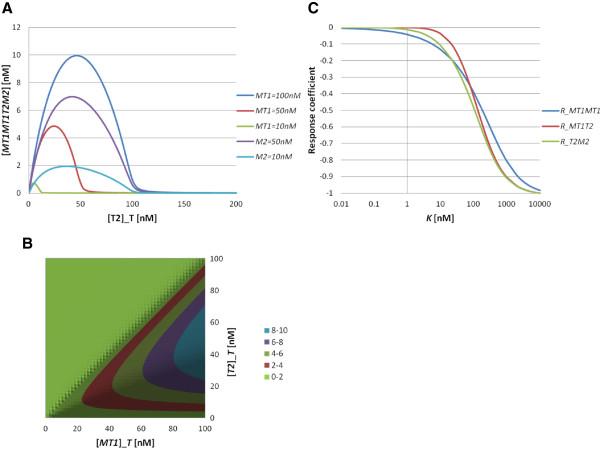
Behaviour of the steady state of the MMP model. (A) Complex concentration [MT1MT1T2M2] as a function of total TIMP2 concentration for different total MT1-MMP and MMP2 concentrations. Blue line indicates [MT1]T = 100nM, [M2]T = 100nM. Red line indicates [MT1]T = 50nM, [M2]T = 100nM. Green line indicates [MT1]T = 10nM, [M2]T = 100nM. Purple line indicates [MT1]T = 100nM, [M2]T = 50nM. Cyan line indicates [MT1]T = 100nM, [M2]T = 10nM. (B) Concentration map of the complex concentration [MT1MT1T2M2] as a function of total MT1-MMP and TIMP2 concentrations. Here, we set [M2]T = 100nM. (C) The response coefficients of the MMP model for the three interactions: the MT1-MMP dimerization, the MT1-MMP and TIMP2 binding, and the TIMP2 and MMP2 binding. The blue line shows the response coefficient RMT1MT1 = ∂ ln [MT1MT1T2M2]/ ∂ ln KMT1MT1 as a function of KMT1MT1, the red line shows the response coefficient RMT1T2 = ∂ ln [MT1MT1T2M2]/ ∂ ln KMT1T2 as a function of KMT1T2 and the green line shows the response coefficient RT2M2 = ∂ ln [MT1MT1T2M2]/ ∂ ln KT2M2 as a function of KT2M2. Here, we set [MT1]T = 100nM, [T2]T = 50nM and [M2]T = 100nM.